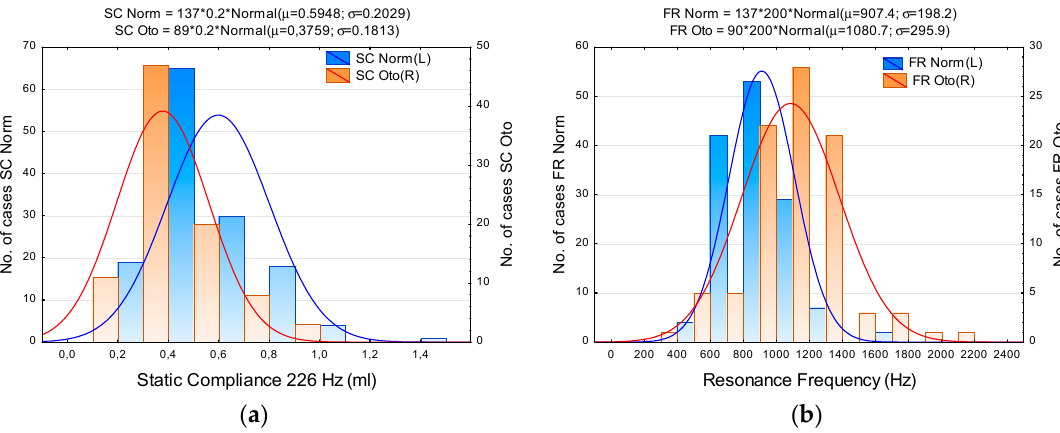
Figure 5. Histograms of static compliance ( a ) and resonance frequency ( b ) in the Normal (blue) and Otosclerotic (orange) groups. Key: SC Norm, SC Oto, FR Norm, FR Oto — Static compliance and resonance frequency in Normal and Otosclerotic groups, respectively; bars — number of cases in consecutive intervals, continuous lines — fitted normal distribution.